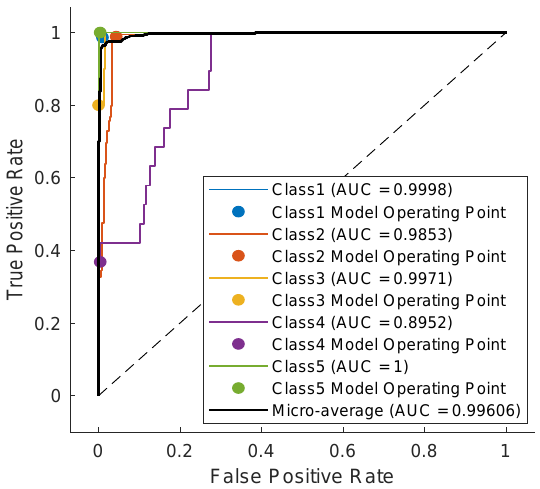
Figure 7. Confusion matrix of the TCN model proposed in Experiment 1 of Table 1, applied to the ECG5000 dataset.